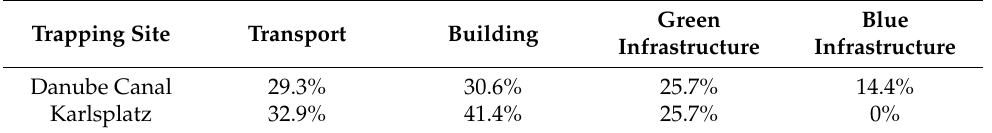
Table 2. Land-use categories within the rat home range (based on a 200 m-radius buffer surface around each capture point) shown in average percentage for the two trapping sites in Vienna, Austria.